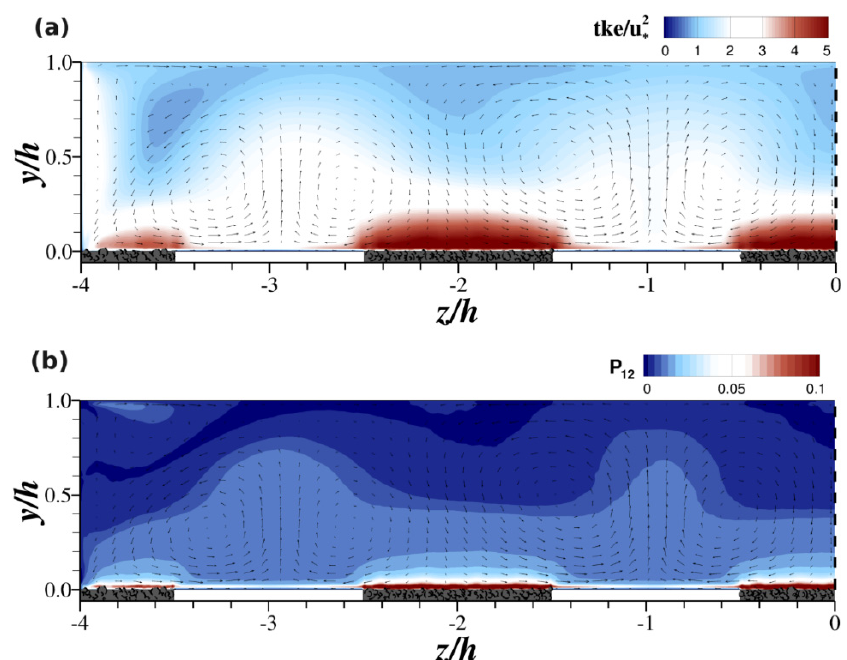
Figure 9. Contours of the normalized turbulent kinetic energy ( a ) and normalized dominant turbulence production term ( b ) in the left half of the